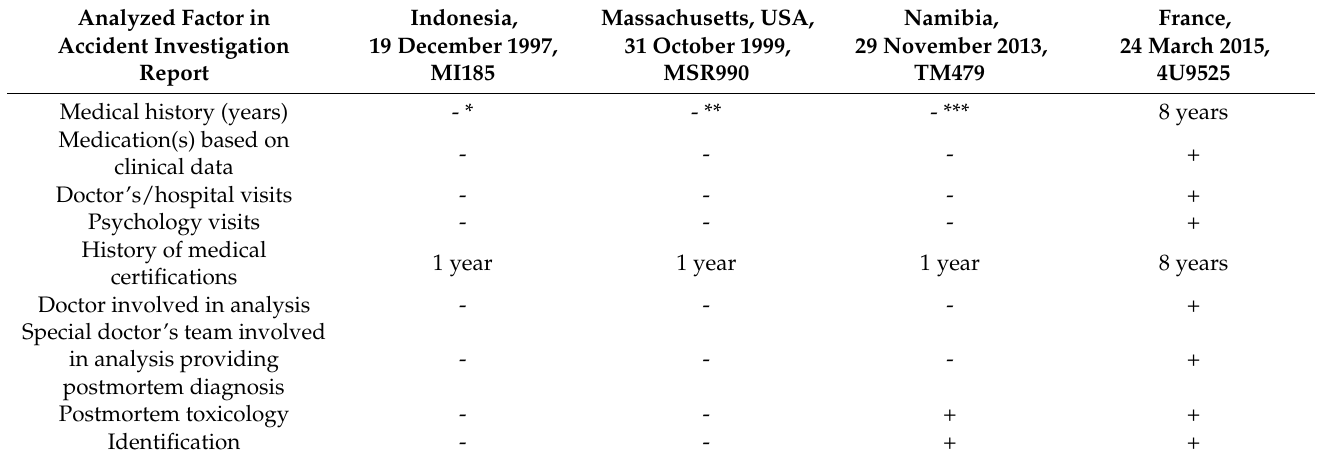
Table 2. Documented medical and pathological information collected in accident investiga- tions